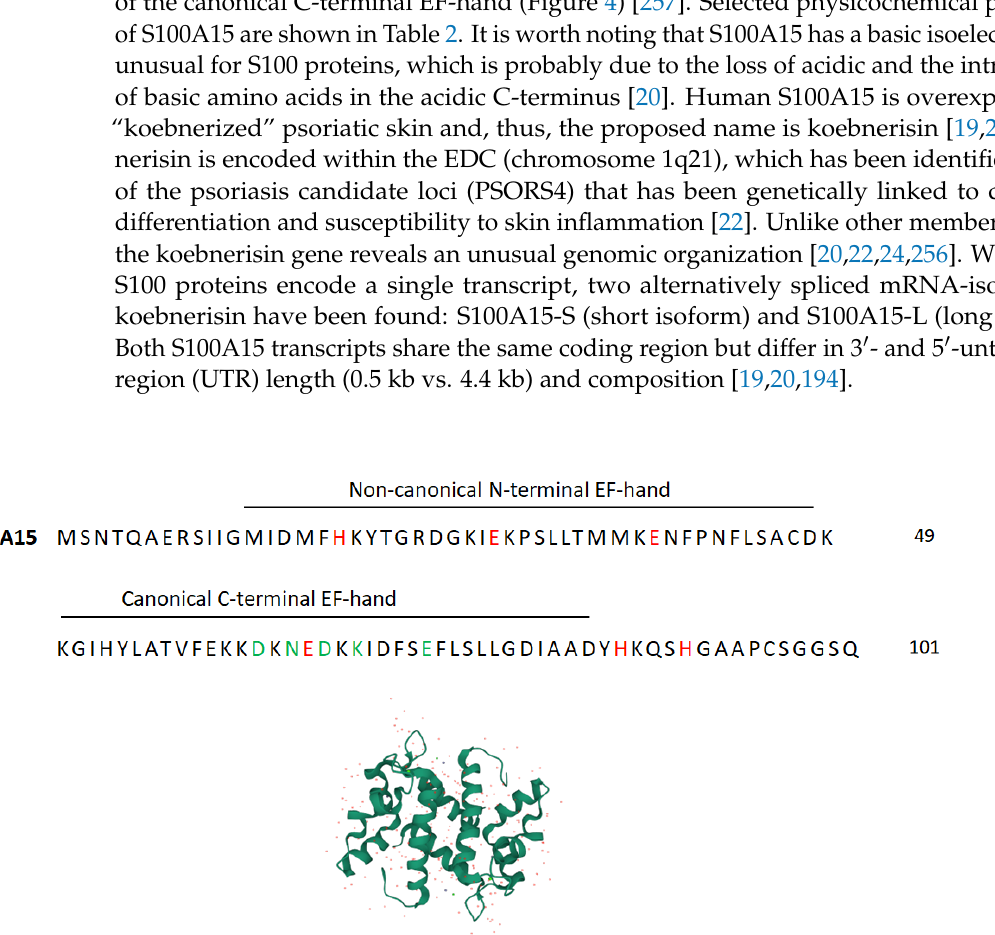
Table 2. Chemical and physical properties of S100A15 [20,258,259].